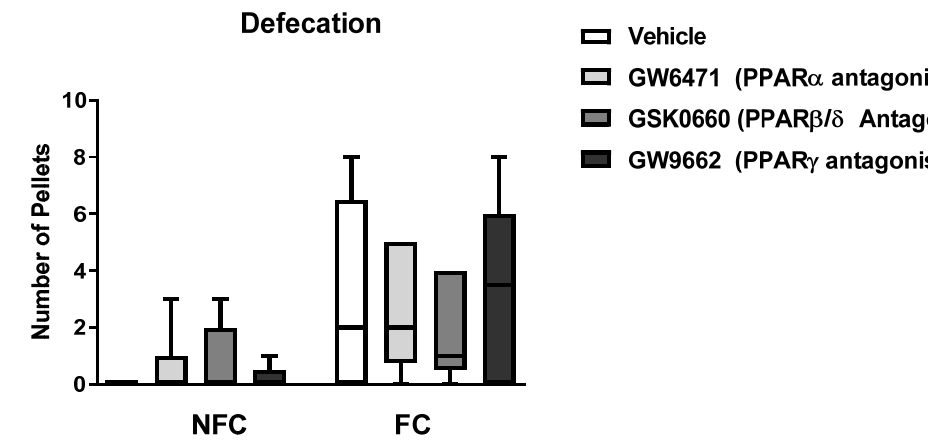
Figure 4. Effects of fear conditioning and intra-BLA administration of selective PPAR α , PPAR β / δ , and PPAR γ antagonists on defecation. Data are expressed as median with interquartile range and min/max ( n = 7–9 rats per group).